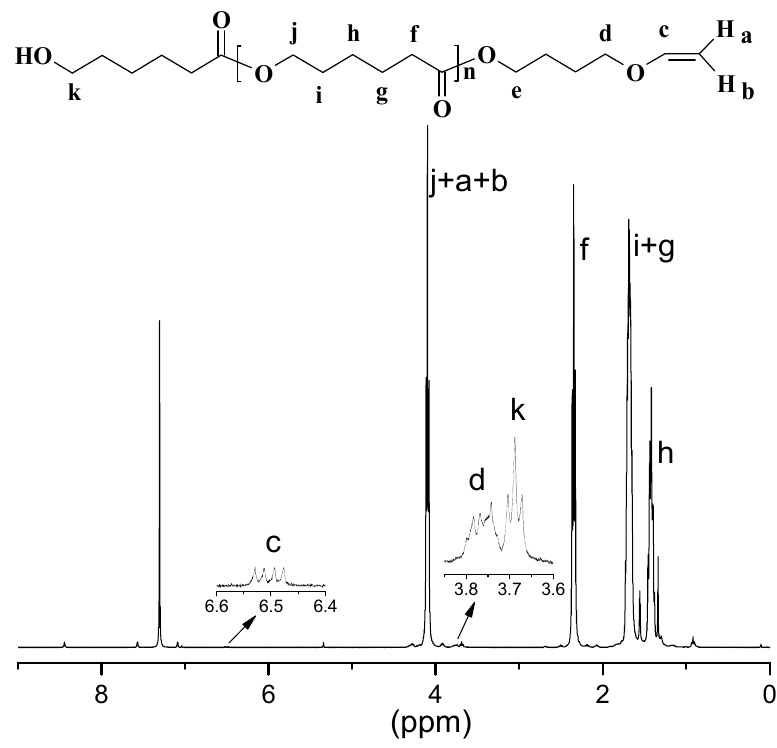
Figure 4. 1 H NMR spectrum of poly( ε -caprolactone) synthesized with 3b at 80 ° C and at [ ε -caprolactone]/[catalyst] = 100.